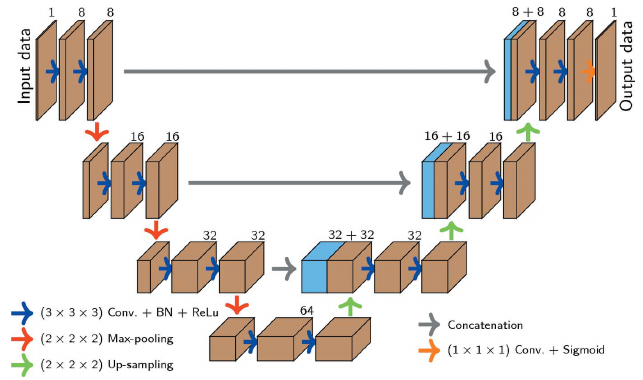
Figure 1 The 3D U-net DCNN used in the present work has four layers and base-8 characteristic features. Arrows represent the different operations and brown and blue boxes represent the multi-channel and copied feature volumes, respectively. The input and output volumes are gray-scale data with the same pixel size